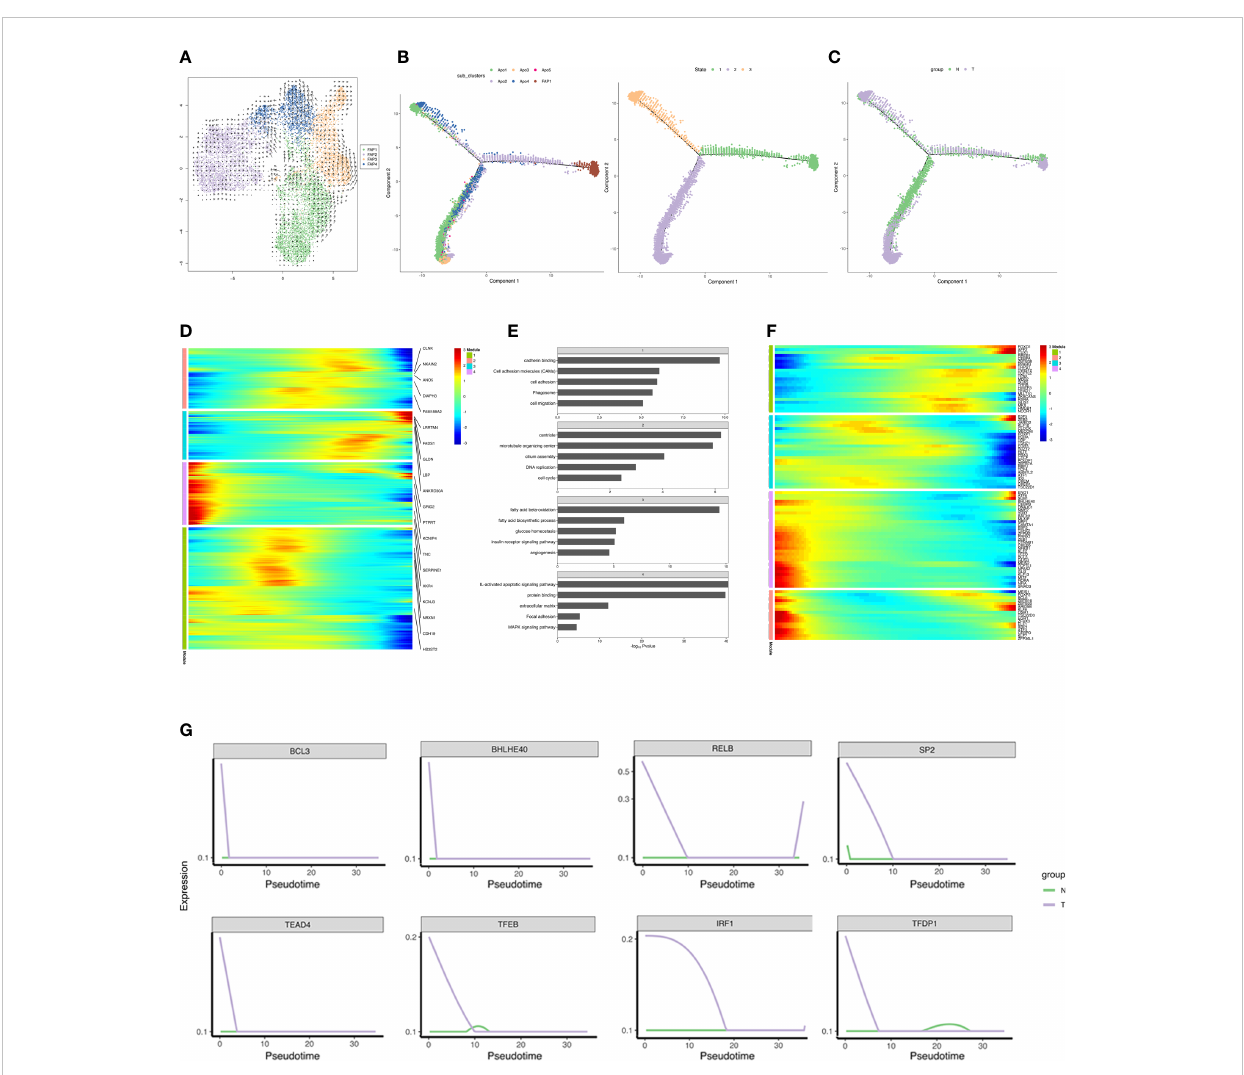
FIGURE 6 Reconstruction of adipogenesis in vivo. (A) RNA velocity analysis of FAPs. The velocities were layered on top of the FAP subpopulations in UMAP space (Figure 4A). The results of RNA velocity are mapped to the UMAP dimensionality reduction cluster diagram. The points in the diagram represent cells, the colors represent different cell types/cell clusters, and the arrow direction represents the cell differentiation direction predicted by the algorithm. (B, C) Monocle analyses showing the development of FAP and adipocyte along the pseudotime trajectory. The left fi gure in B shows the pseudo-time trajectory of cell cluster differentiation, and each color represents a cell cluster, the right fi gure in B shows the pseudo-time trajectory of cell differentiation state, and each color represents a cell state. (C) shows the pseudo-time trajectory of cell differentiation in different group, and each color represents a group. (D) Heatmap showing the differentially expressed genes in each module (along pseudo-time across the trajectory) in T group, and we listed the top 5 DEGs in each module in the fi gure. Each row represents a gene, the horizontal axis from left to right represents the time from morning to night, and the color from blue to red represents the expression of genes from low to high. Clustering of genes with similar expression patterns in the time development track. The colors represent different module. (E) Barplot showing the signi fi cance levels of the top 5 most signi fi cantly enriched pathways in each gene group (all DEGs in D ). The numbers in the gray grid above each histogram represented the corresponding module in panel (D) . (F) Heatmap showing expressions of transcriptional regulators differentially expressed along pseudo-time across the trajectory. Each row represents a gene, the horizontal axis from left to right represents the time from morning to night, and the color from blue to red represents the expression of genes from low to high. Clustering of genes with similar expression patterns in the time development track. (G) Pseudotime ordered single-cell expression trajectories of TFs in N and T group. The horizontal axis from left to right represents the time from early differentiation to late differentiation. The vertical axis represents the amount of gene expression. Lines with different colors represent different